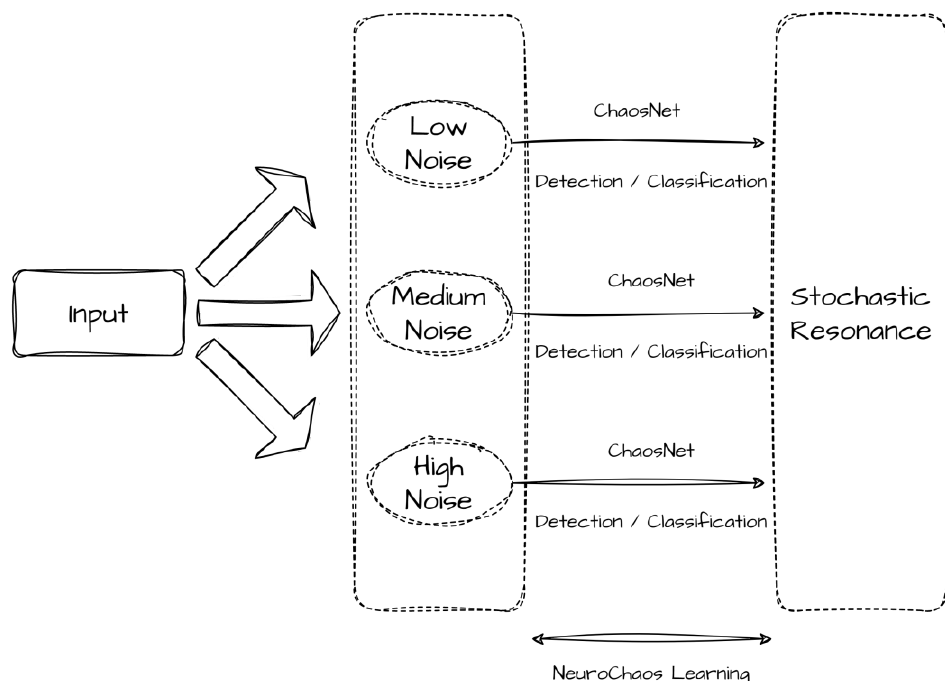
Figure 1. Neurochaos Learning (Harikrishnan and Nagaraj 2021).